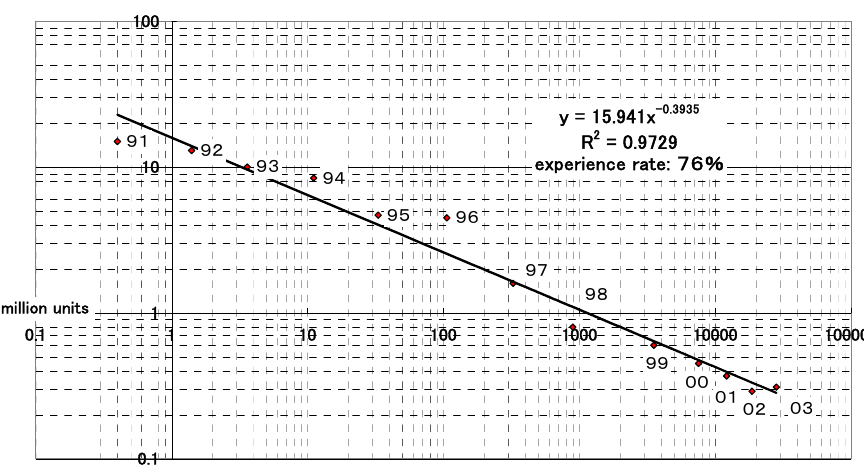
Figure 10. Experience curve of CD-R